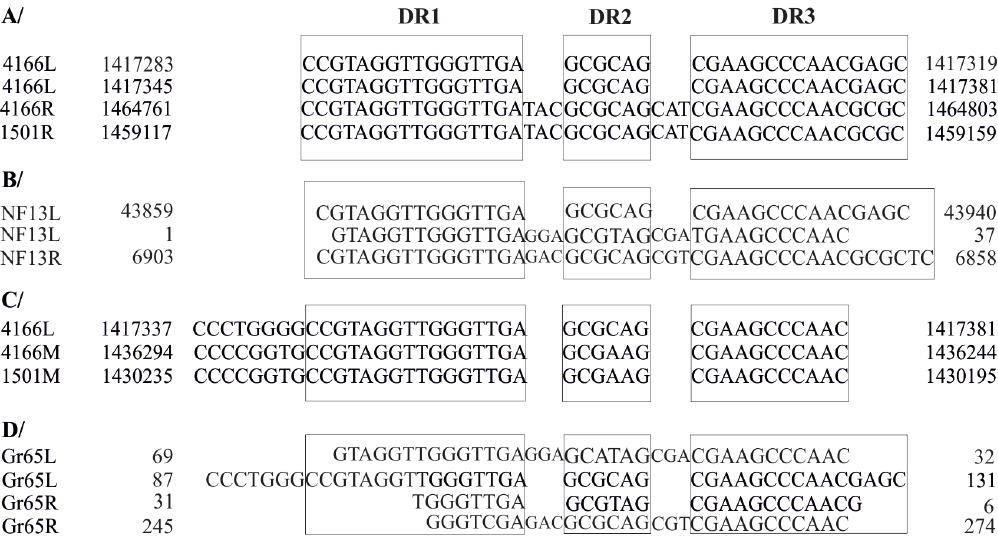
Figure 2. Inverted and/or direct repeats identified in the IRLeft and IRRight regions flanking the nitrogen fixation island of P. stutzeri strains and Pseudomonas sp. Gr65. The repeats DR1, DR2 and DR3 (boxed) present in the IRLeft and IRRight regions flanking the nitrogen fixation island of P. stutzeri A1501 and DSM4166 (A), P. stutzeri NF13 (B) and Pseudomonas sp. Gr65 (D). The repeats located in the intergenic region between PST_1322- PST_1323 (designated as 1501 M ) and PSTAA_1354- PSTAA_1355 (designated as 4166 M ) (C). The coordinates displayed on the left and the right side of the sequences indicate the position of the sequences in genome of P. stutzeri A1501 or DSM4166 (A and C). The coordinates displayed for Pseudomonas sp. Gr65 were based on the nucleotide sequences of IRLeft and IRRight found in the files S1 and